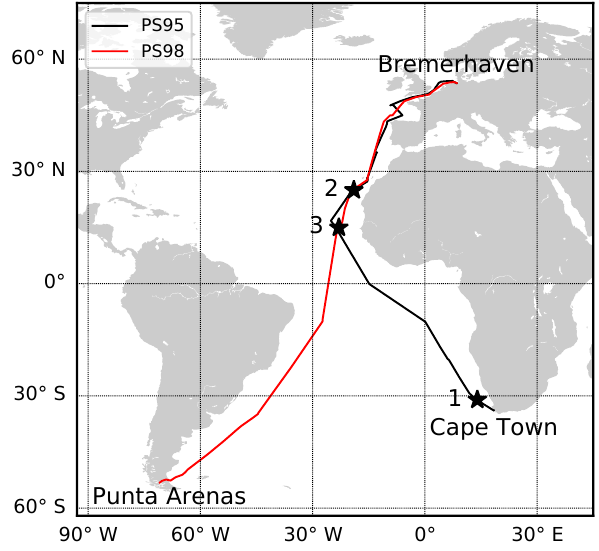
Figure 1. RV Polarstern cruises with Polly XT aboard. Cruise tracks are taken from the Pangaea database (https://www.pangaea.de/ expeditions/cr.php/Polarstern, last access: 24 February 2017). Black stars mark the location of the case studies presented in Sect.